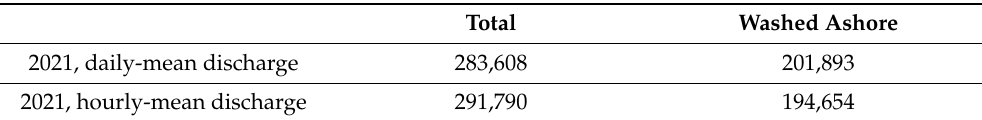
Table 2. The number of Lagrangian particles washed ashore during the July rain-induced flash floods in